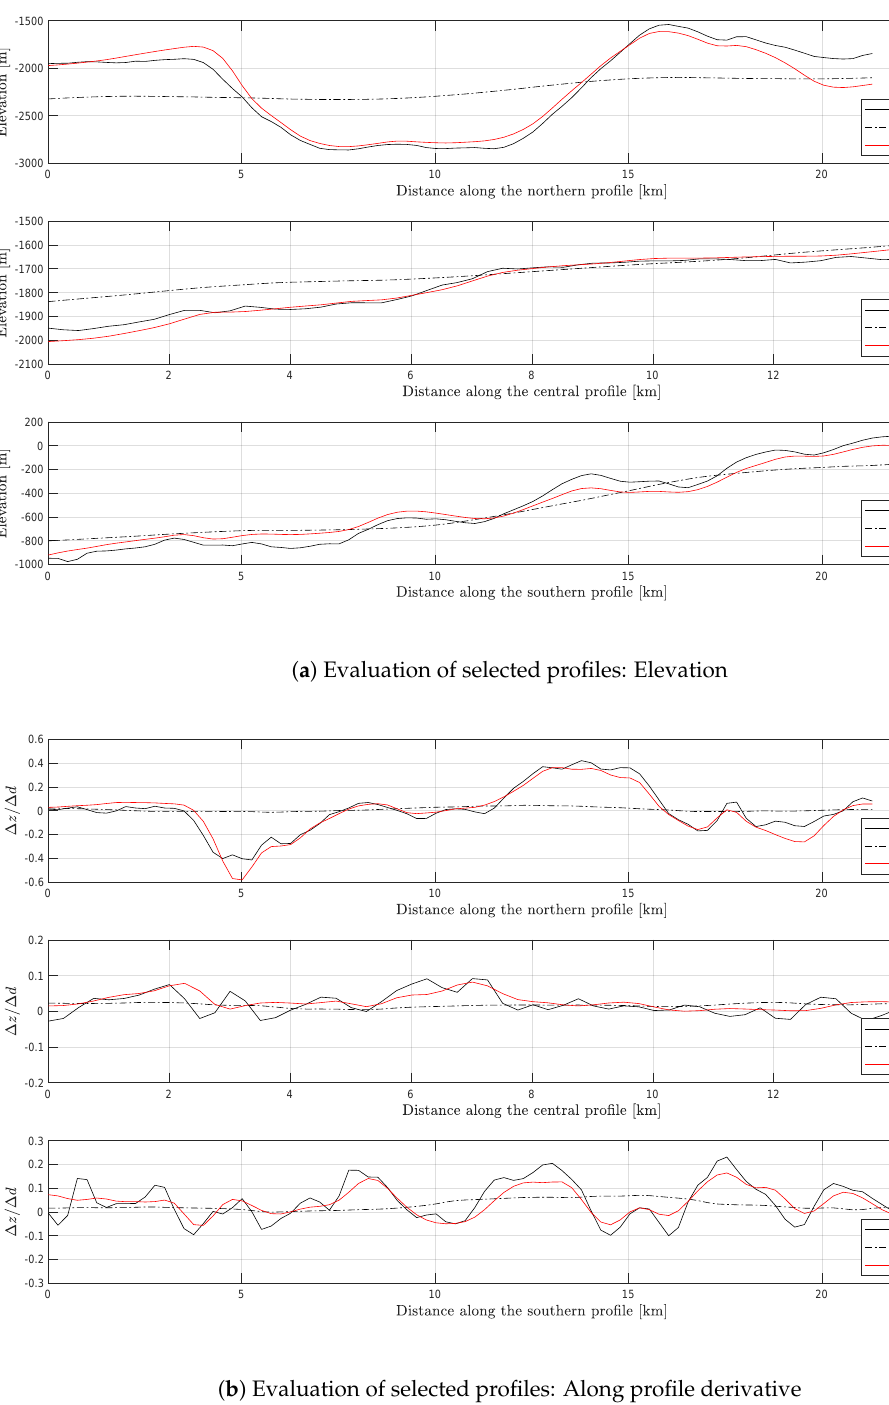
Figure 9. ( a ) Elevation of the northern, central, and southern profile marked in Figure 8. The elevations of the initial DTM (black dotted) and the SfS DTM (red) are compared to the reference DTM (black). ( b ) First derivative of the reconstructed surface along the same profiles. The along profile derivative of the initial DTM (black dotted) and the SfS DTM (red) are compared to the derivatives of the reference DTM (black). Starting from the low frequency initialization, the SfS algorithm is able to reconstruct the shape of the